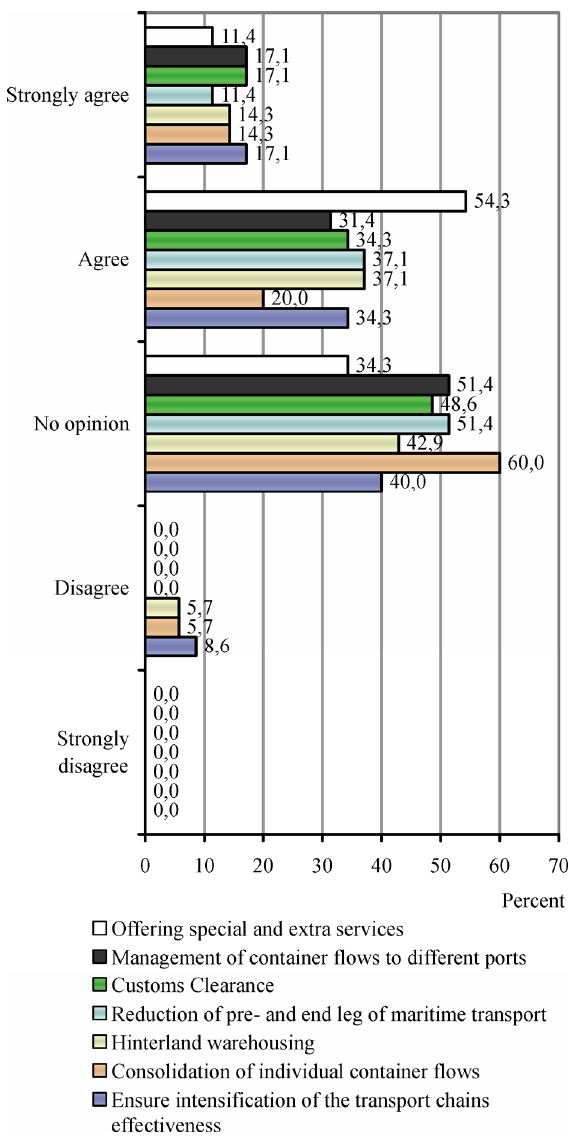
Fig 5. The functions available in the dry ports